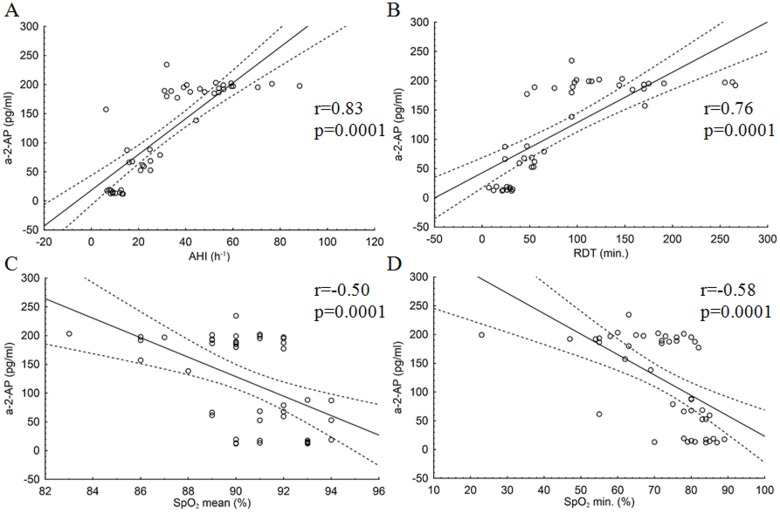
Correlations between selected polysomnographic parameters and a-2-AP concentration in patients with OSA.Correlations between a-2-AP concentrations and polysomnographic parameters: (A) AHI, (B) RDT, (C) SpO2 mean, (D) SpO2 min. r and p values were calculated by Spearman’s rank order correlation test.